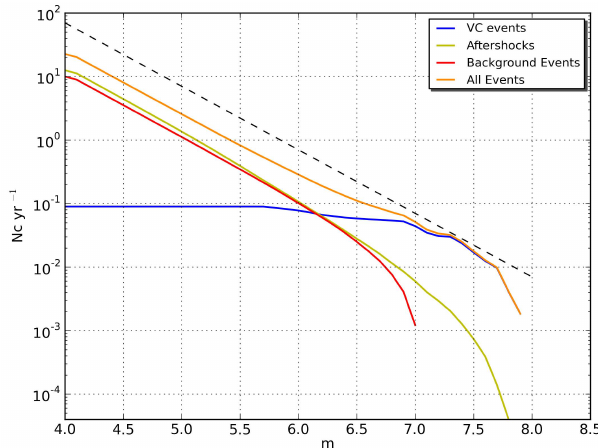
Fig. 8. Cumulative frequency-magnitude statistics for simulated earthquakes in northern CA with magnitudes greater than 4. The cumulative numbers of earthquakes per year Nc with magnitudes equal to or greater than m are given as a function of M . Included are: (1) Earthquakes on the VC faults. These earthquakes are pre- dominantly in the magnitude range 7 to 8, the mean recurrence in- terval is about 10yr. (2) Other background events, they have the prescribed GR magnitude statistics with a mean recurrence inter- val of about 0.1yr. (3) Aftershocks generated by the BASS model. The mean recurrence interval is also about 0.1yr. The distribu- tion for all earthquakes is also shown. On average there are about 20 M > 4 earthquakes per year. The dashed line is the GR distribu- tion, Eq. (2), with b =